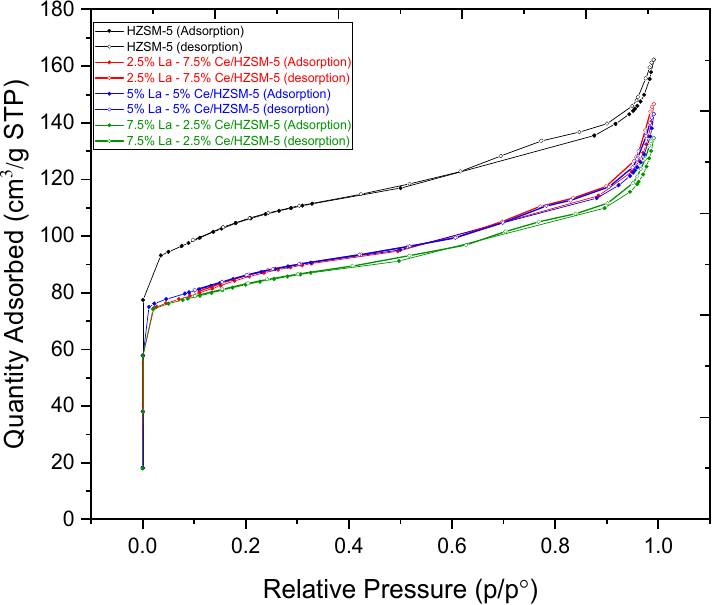
Figure 7. N 2 adsorption-desorption isotherms of the parent HZSM-5 and Lanthanum-Cerium-modified HZSM-5 with different loading weight percentages.